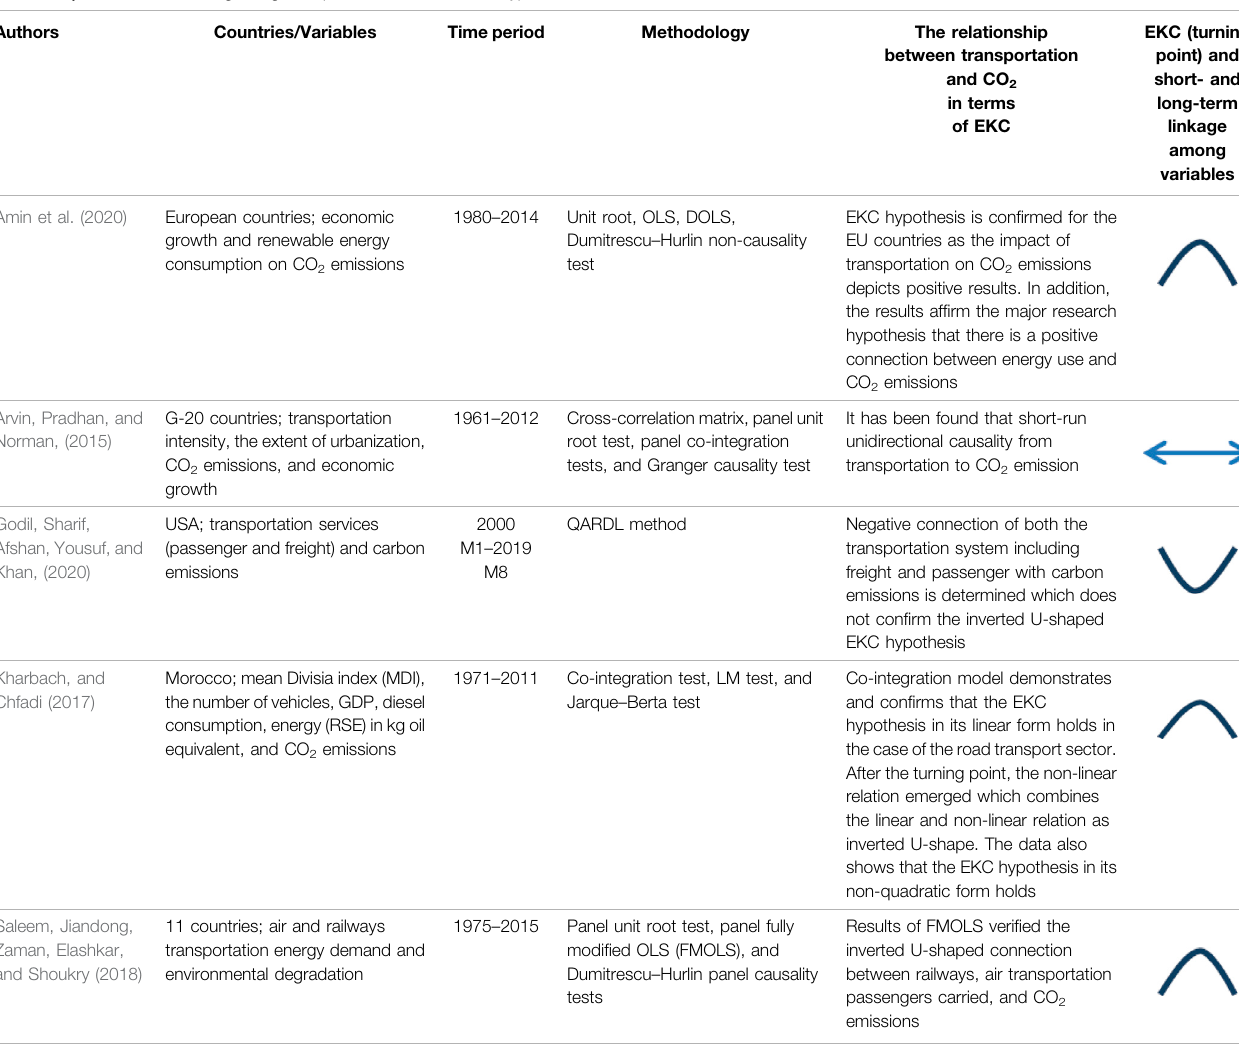
TABLE 1 | Literature review regarding transportation-induced EKC hypothesis in terms of main